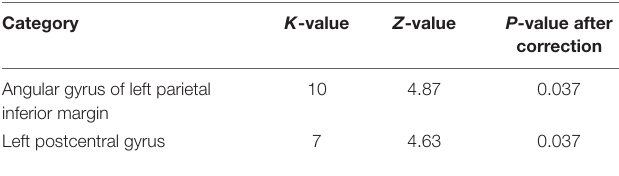
TABLE 2 | ReHo value statistics of high-stress